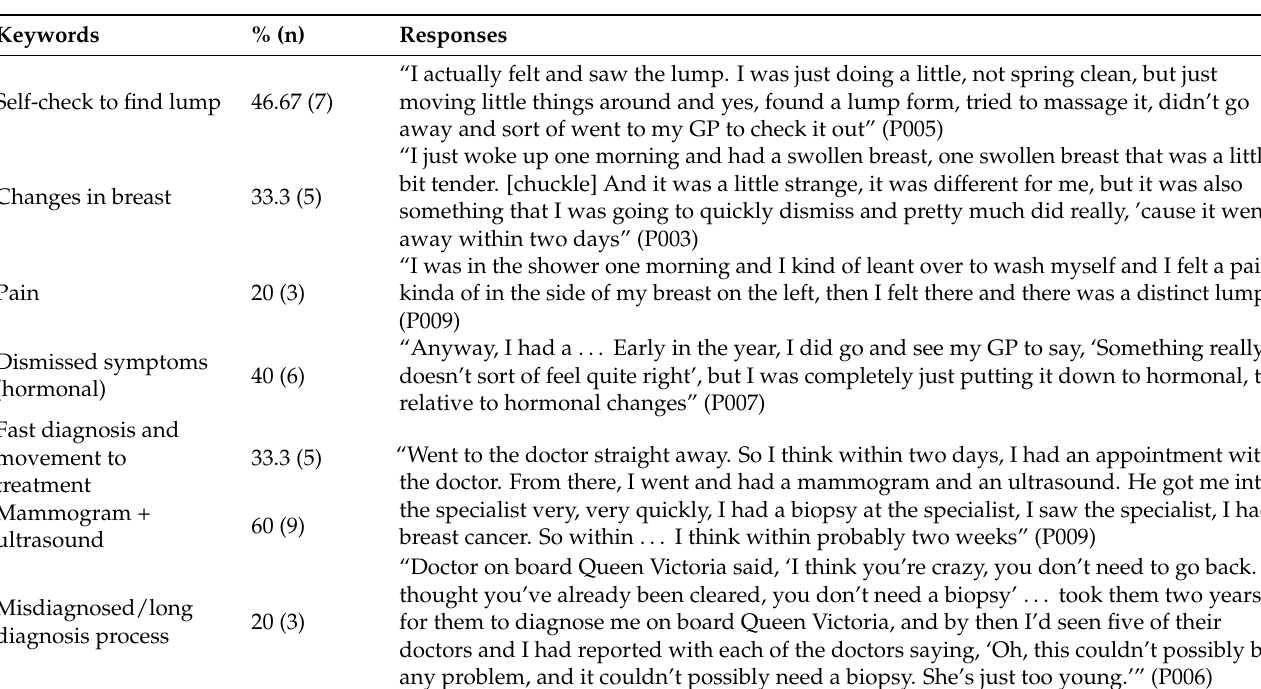
Table 3. Experience of Breast Cancer. How did you find out you had breast